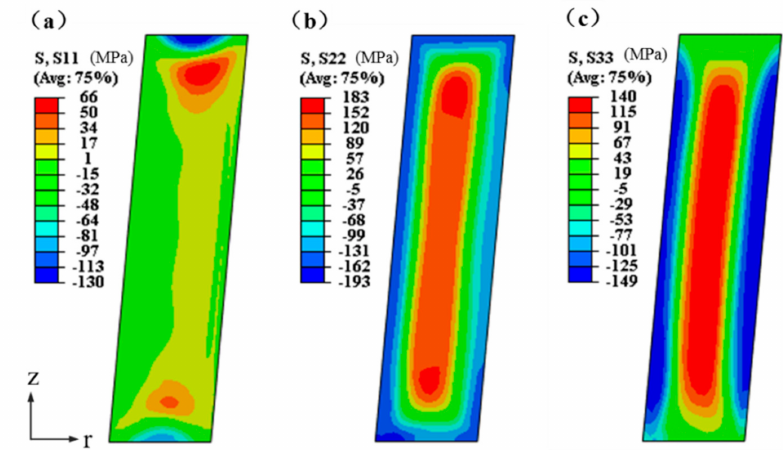
Figure 7. Residual stresses nephogram of the 2A14 tapered cylinder forging in the r-, t-, and z- directions after quenching: ( a ) σ r ; ( b ) σ t ; and ( c ) σ z